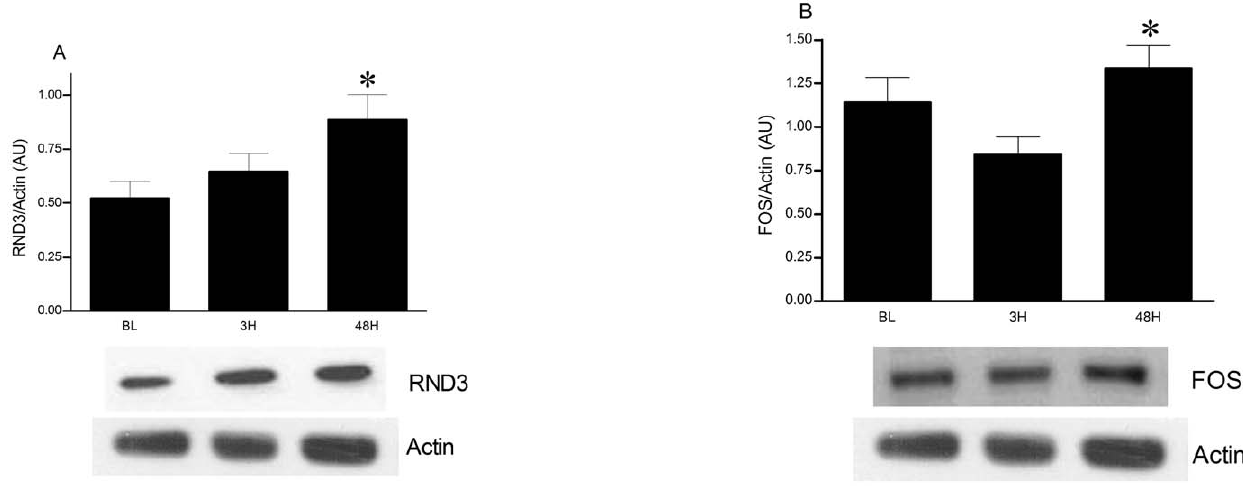
Figure 4. Western blot analysis of RND3 and FOS in skeletal muscle after eccentric exercise. BL = baseline, 3H=3 hours post exercise, 48H=48 hours post exercise. Graph A – RND3 (N=18). Graph B – FOS (N=14). Values are mean 6 SEM. *Significant difference vs. baseline when collapsed across supplementation (P , 0.05).